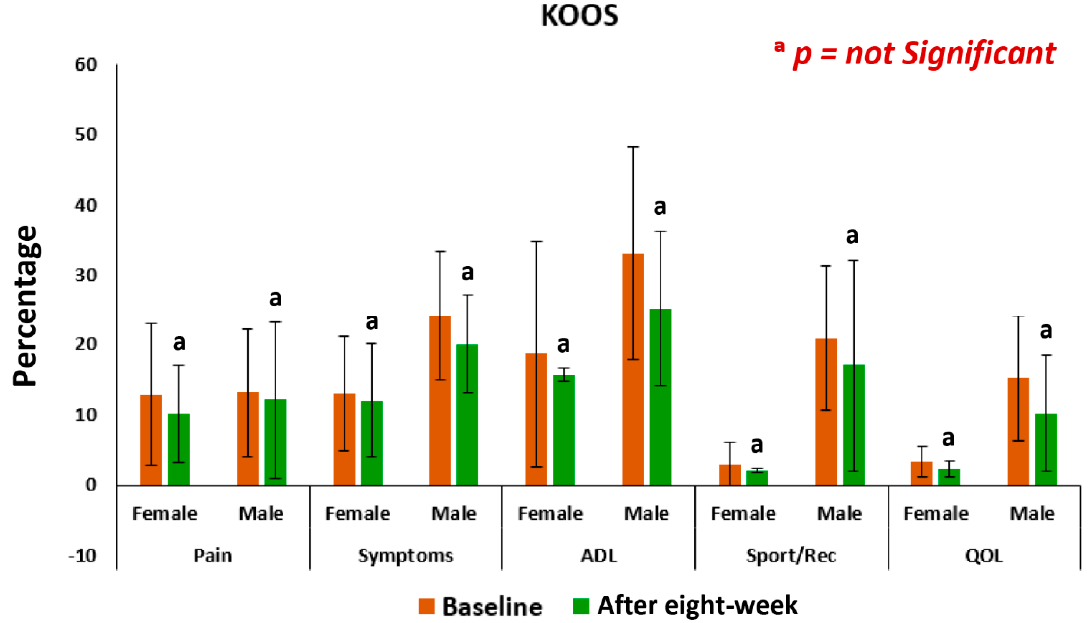
Figure 10. Analysis of knee-injury osteoarthritis outcome scale of 45 control subjects, female ( n = 27) Figure 9. Analysis of knee ‐ injury osteoarthritis outcome scale of 45 control subjects, female ( n = and male ( n = 18), before and after eight-week without supplement ( a p = not significant), ADL: Activities 27) and male ( n = 18), before and after eight ‐ week without supplement ( ᵃ p = not significant), ADL: of daily living; QOL: Quality of Activities of daily living ; QOL: Quality of life.